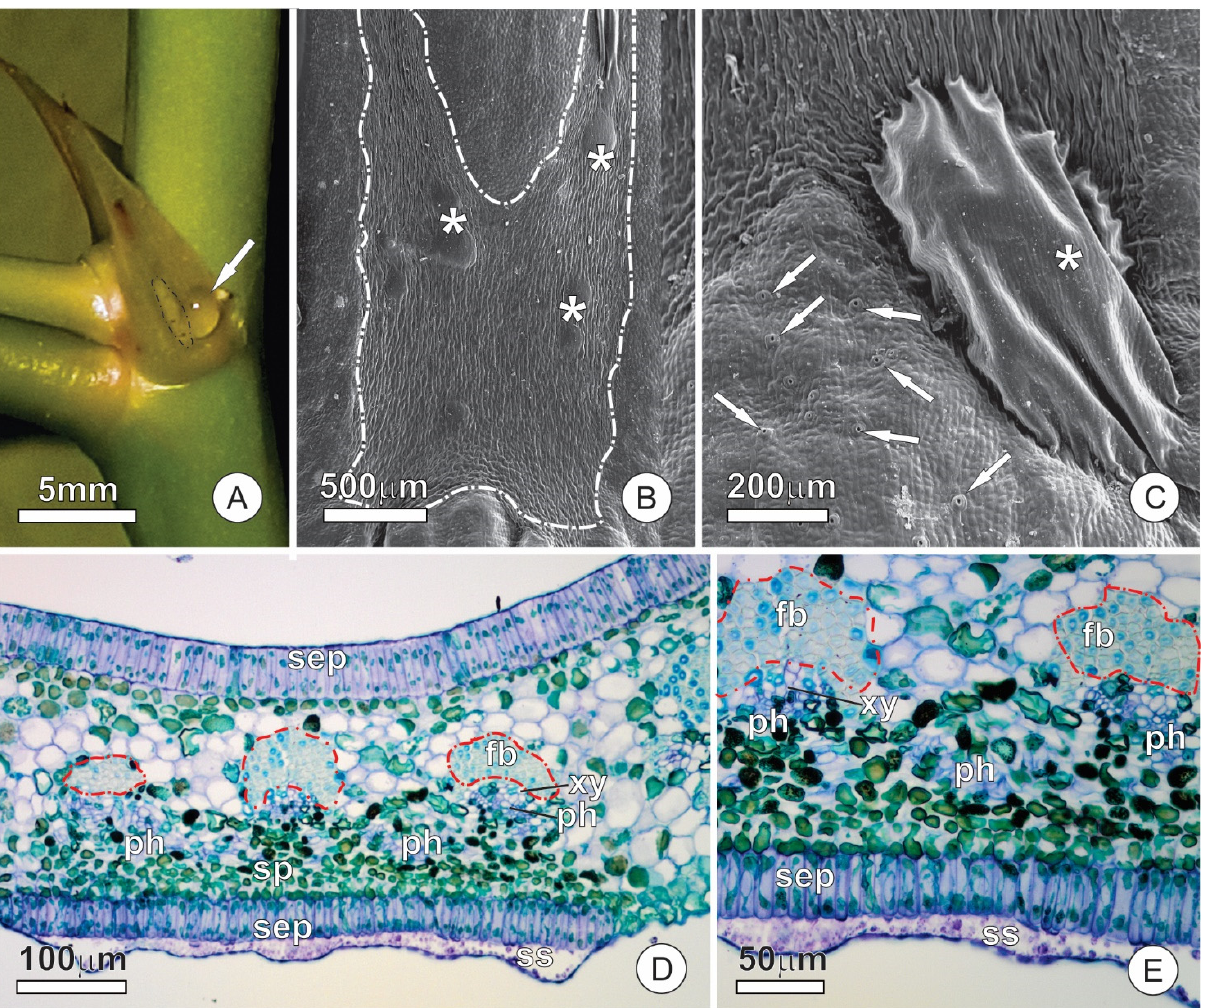
Figure 6. Structural aspects of extrafloral nectaries in stipules of O. castaneifolia : ( A ) Overview of a nectary (dashed line) in a stipule. Note the large nectar droplet (arrow). ( B – C ) Surface view of the nectary showing conspicuous subcuticular spaces (*) where nectar accumulates before being released. In C, note the contrasting presence of stomata (arrows) on the ordinary surface of the stipule versus their absence over the nectary. ( D ) Cross-section of a stipule with a resin gland on the adaxial surface and a nectary on the abaxial surface. ( E ) Cross-section of a stipule showing the nectary portion. Note the dense arrangement of the subglandular parenchyma of the nectary and the presence of a large subcuticular space. A fiber cap (red dashed line), which is interrupted towards the nectary, surrounds the vascular bundles. fb = fiber cap, ph = phloem, sep = secretory epidermis, sp = subglandular parenchyma, ss = subcuticular space, xy = xylem.